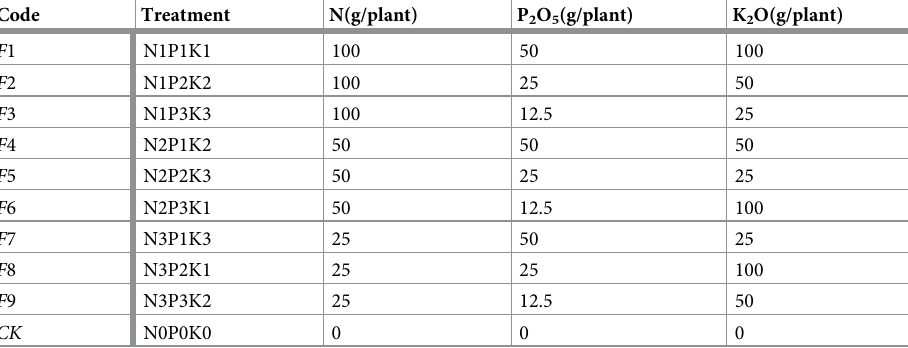
Table 2. Treatments of N, P and K with their dosages on blueberry